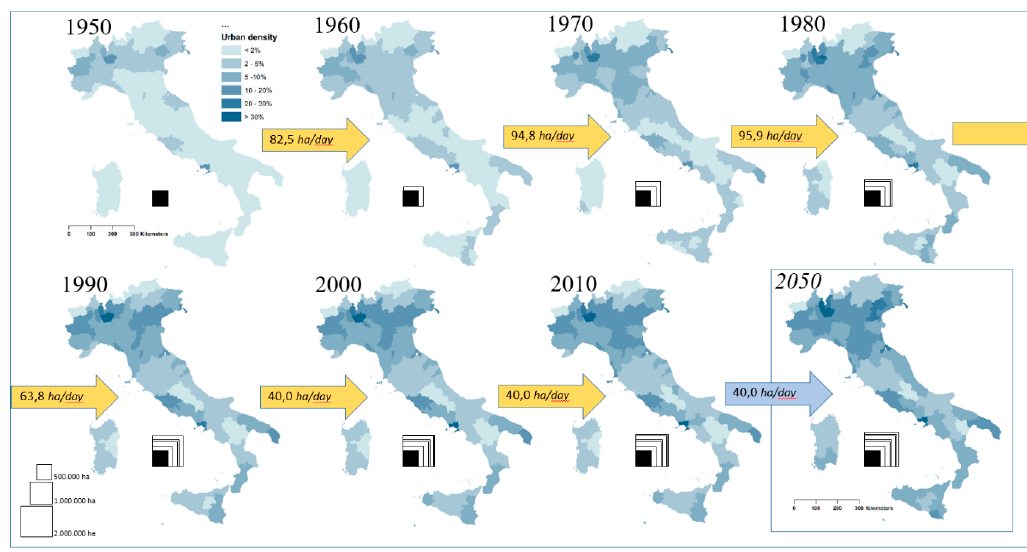
Figure 5. Gradual increase in urbanization density, with respective rates and land take mean speed ( LT ms ) , in the NUTS 3 administrative territories used as calculation bases in our study. The black box indicates the total amount of urbanized area in the